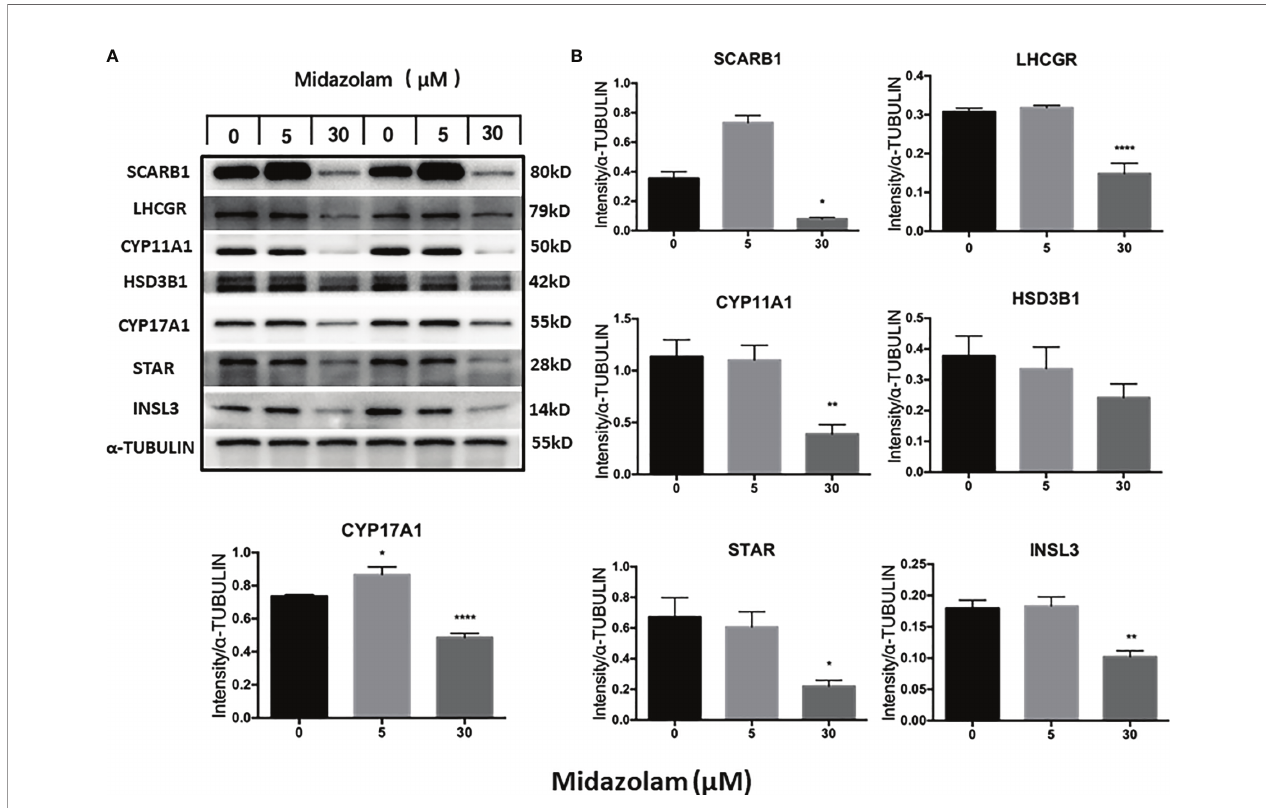
FIGURE 6 | Effects of midazolam on the expression of steroidogenic proteins: stem Leydig cells were induced to differentiate into Leydig cells in the presence of 5 or 30 m M of midazolam for 21 days. Steroidogenic proteins were assayed by Western blotting with a -tubulin as an internal control. (A) Representative Western blotting bands for each protein of two individual experiments. (B) Quanti fi cation of the Western blotting data, which are expressed as mean ± SEM of six experiments. Signi fi cantly different from the control groups at *p < 0.05, **0.01, or